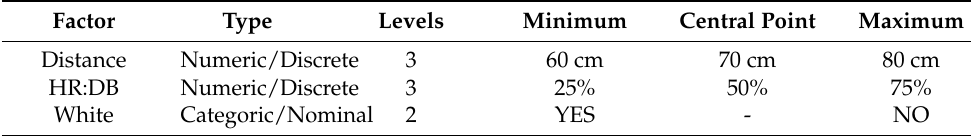
Table 3. Independent variables employed for the statistical